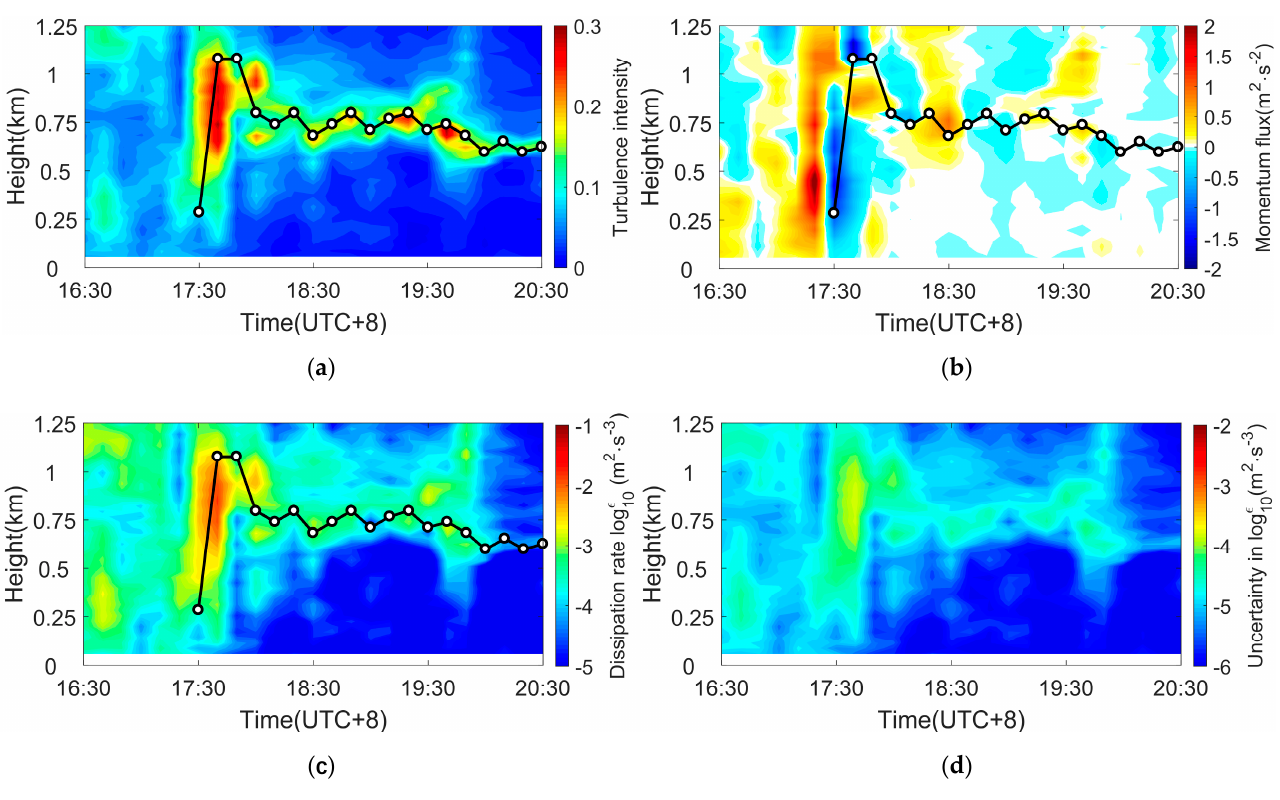
Figure 12. Turbulent parameters during the sea breeze penetration on 25 September 2019. ( a ) the turbulent intensity; ( b ) the momentum flux ( c ) the turbulent dissipation rate; ( d ) the uncertainty in turbulent dissipation rate.